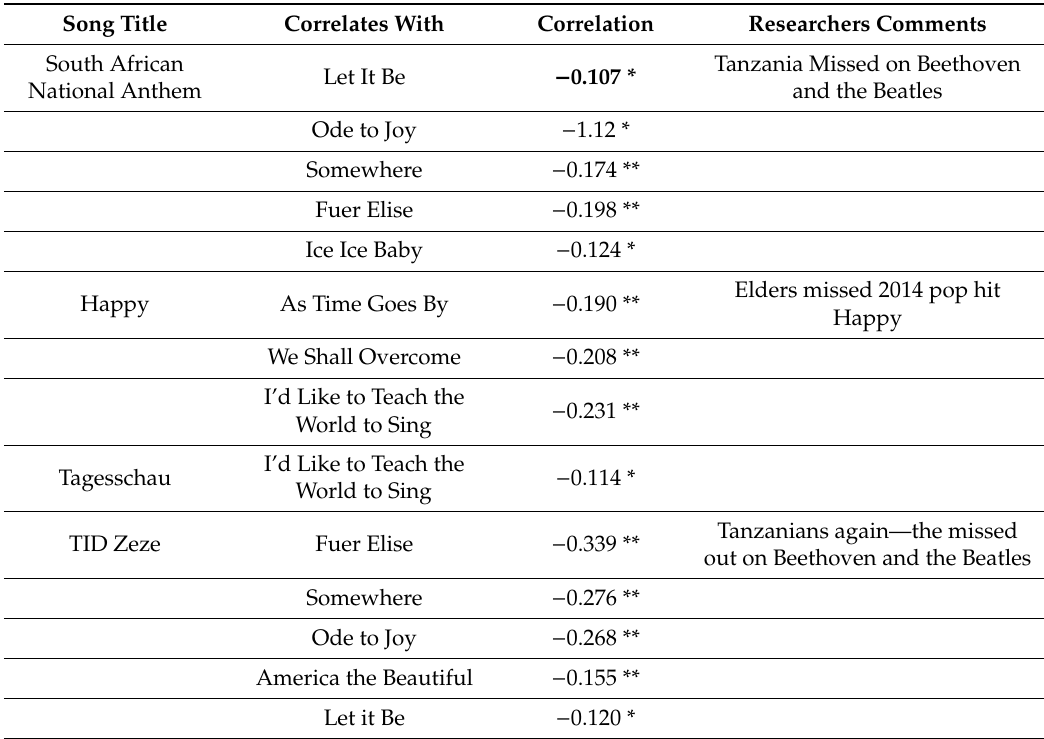
Table 3. Negative Correlations. This Table includes all the statistically significant negative correlations (two asterisks indicate significance at the 0.01 level, and one at the 0.05 level). Most of the significant negative correlations were with the two Tanzanian songs, though there were also three negative correlations with the 2014 song “Happy” and three of the older American songs. The only songs for which there was a weak positive correlation with the South African National Anthem were “I’d Like to Teach the World to Sing,” and “As Times go By” (statistics not